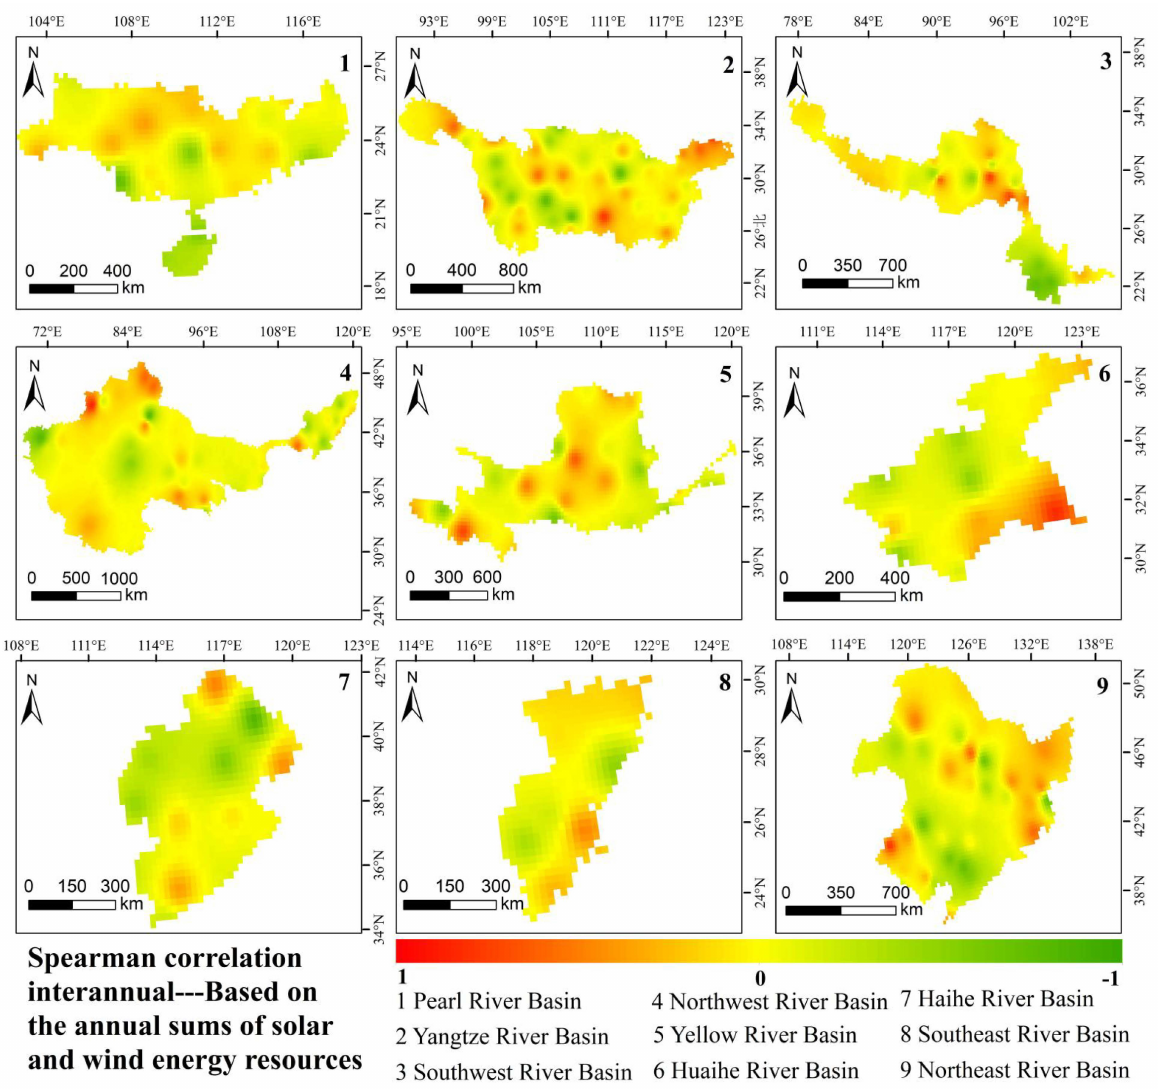
Figure 8. Spatial distribution of complementarity of wind-energy resources and solar-energy re- sources based on total available resources per year in Chinese river